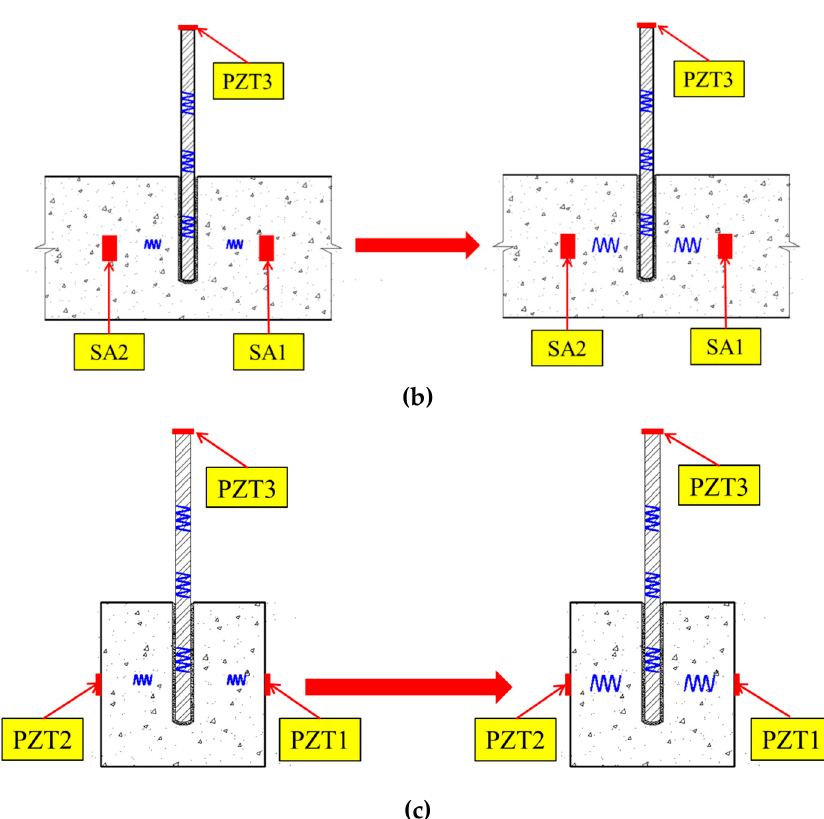
Figure 2. Stress-wave-based active sensing principle for bonding strength monitoring: ( a ) Details of the anchored steel bar in concrete with epoxy; ( b ) Received signals of SA1 and SA2 during the epoxy solidification process; ( c ) Received signals of PZT1 and PZT2 during the epoxy solidification process